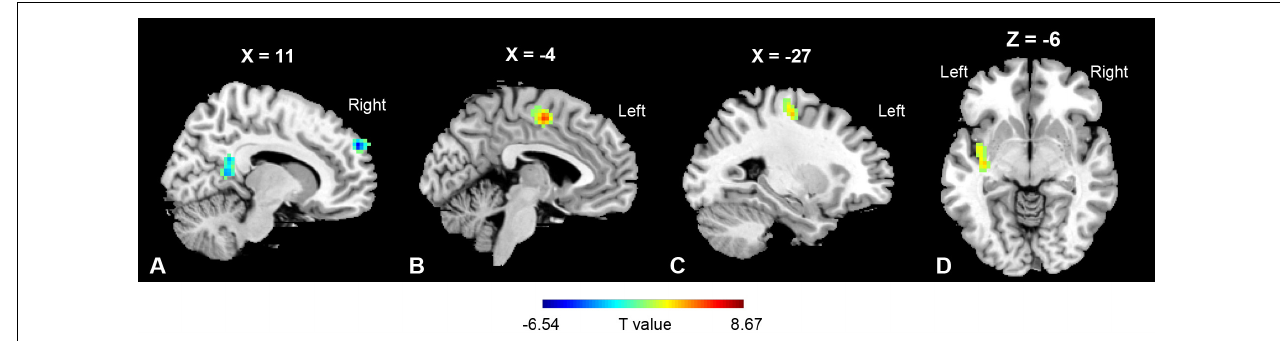
FIGURE 4 | Regions of functional connectivity alterations linked to PoCG.L. PoCG.L related functional connectivity with a significant decrease was observed in (A) right precuneus (200 voxels) and right superior frontal medial gyrus (163 voxels), while that in the (B) mid-cingulate gyrus (126 voxels), (C) precentral gyrus (153 voxels), and (D) insula (103 voxels) in the left side was